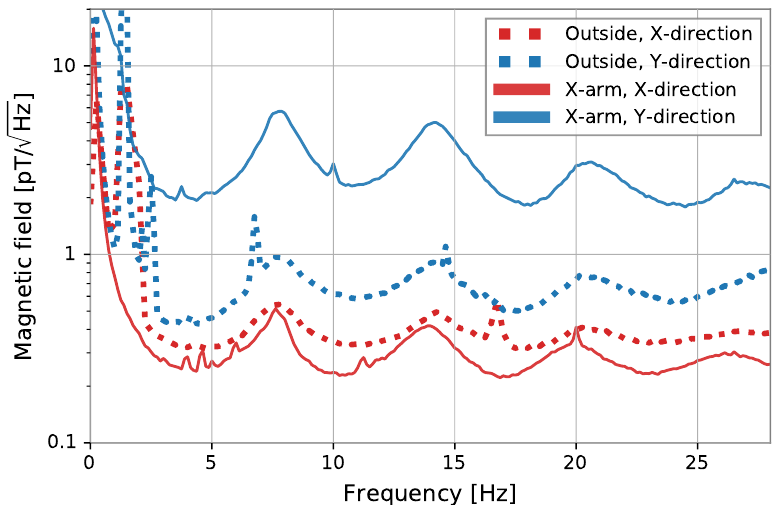
Figure 16. Schumann resonance of magnetic fields measured outside the tunnel (dashed) and inside the X-arm (solid). Red (blue) corresponds to the direction along the X(Y)-arm.